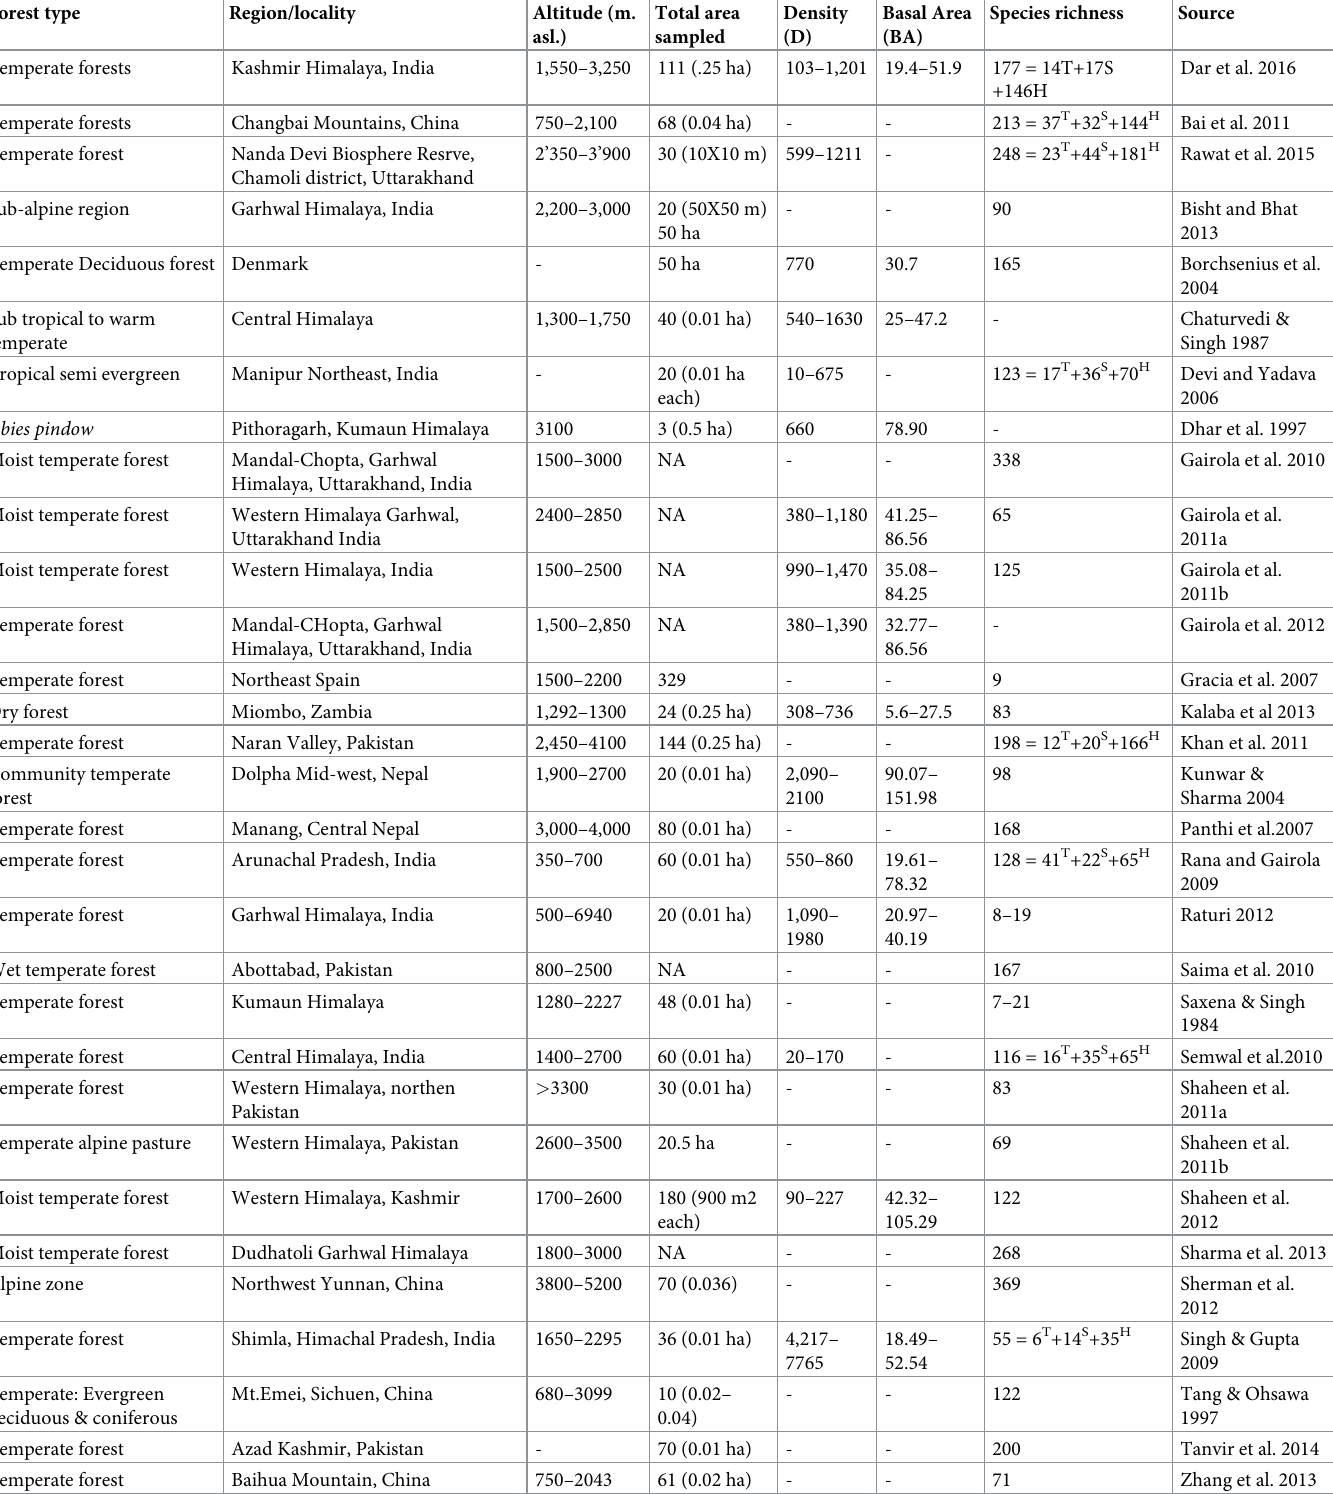
Table 9. Comparisons of phytosociological attributes and species richness of different temperate